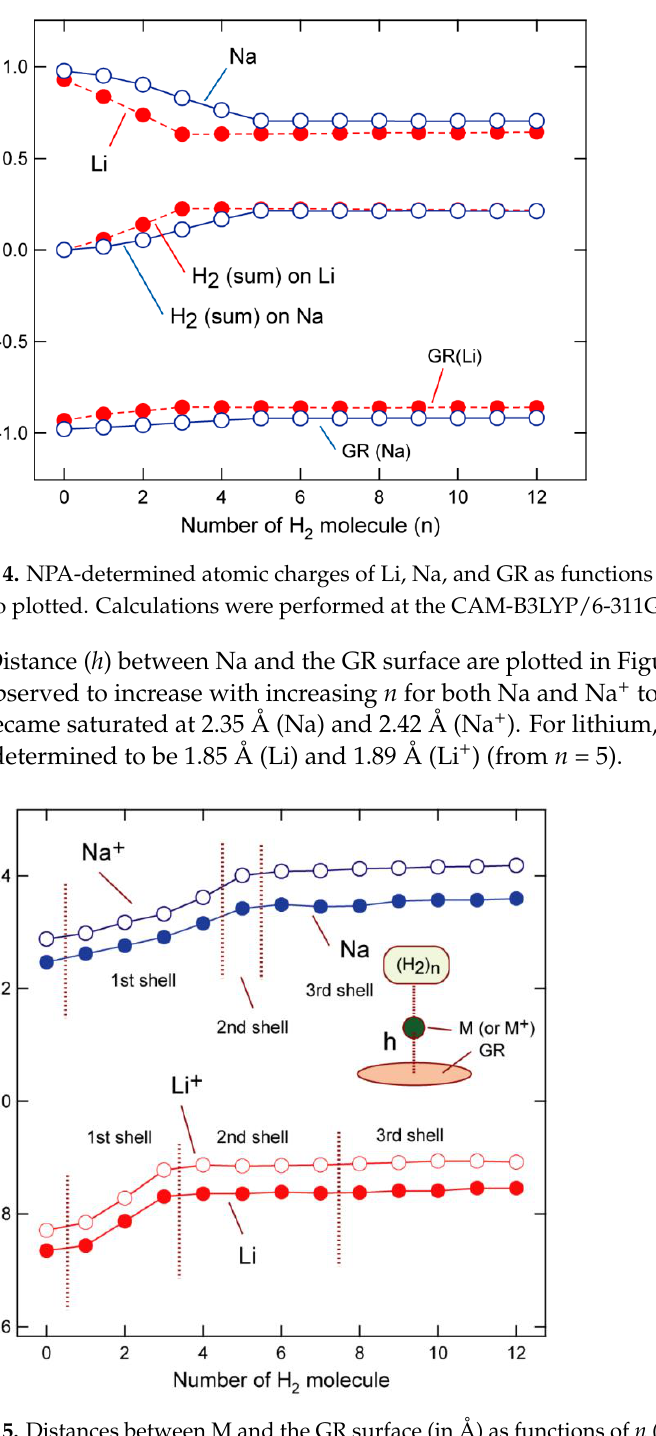
Figure 5. Distances between M and the GR surface (in Å) as functions of n (M = Li, Li + , Na, and Na + ). The Na and Li atoms are always closer to the surface than their corresponding ions (Na + and Li + ). Electrons are transferred from M to GR to form separate M(+1.0)-GR( − 1.0) electronic states in the GR-M (atom) systems. Significant attractive interactions (positive- negative) operate in these GR-M systems that result in shorter M( h )